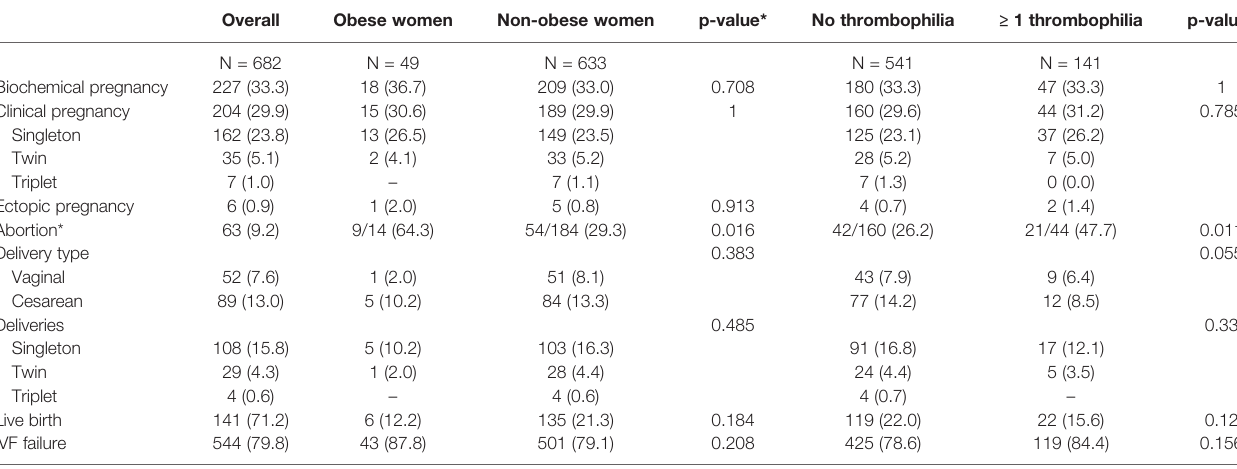
TABLE 2 | In vitro fertilization (IVF) outcomes according to the presence of obesity and thrombophilia.